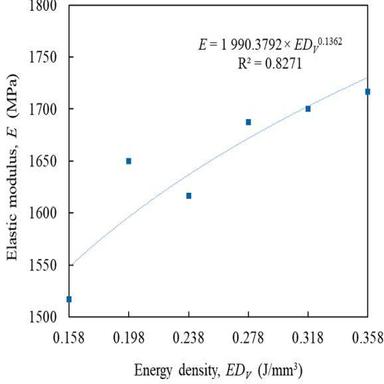
Elastic modulus of SLS test specimens as a function of EDV.